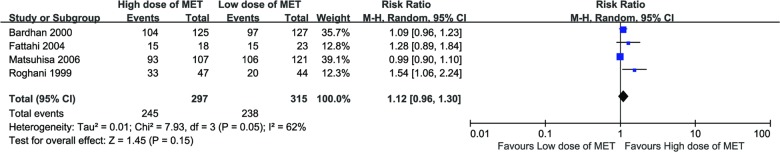
Forest plot of H. pylori eradication rate (intention-to-treat, ITT) with high-dose therapies compared to low-dose therapies.